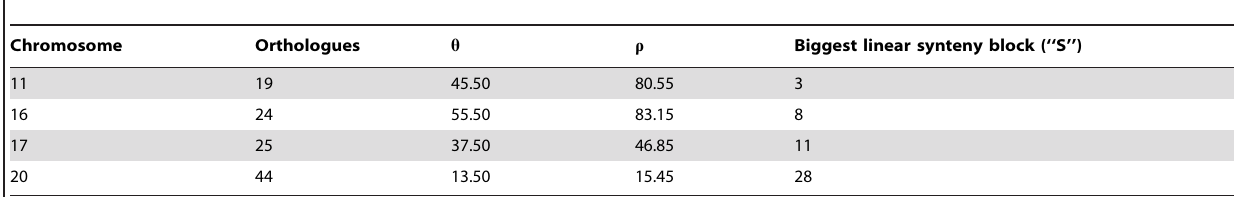
Table 2. Hough transform comparison of synteny between Hsa 8, 60–100 Mb, and Ola 17 and 20.